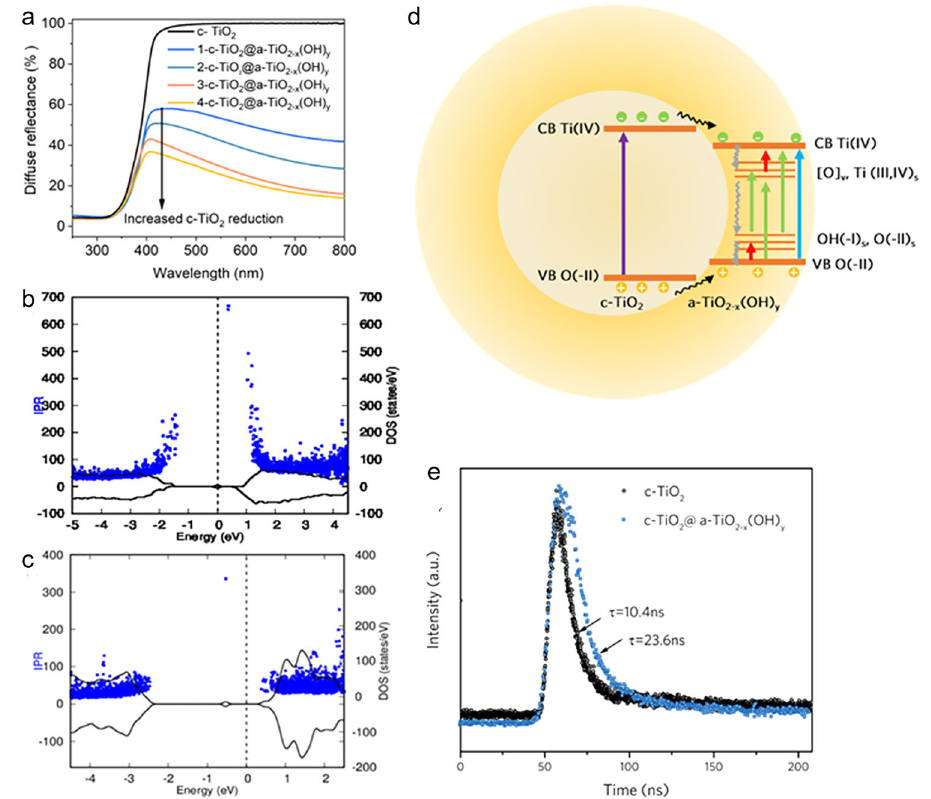
d Schematic of charge carrier separation and transfer pathways in c-TiO 2 @a- TiO 2-x (OH) y .The colorsof arrowsindicatethewavelengthofincidentlight. e Time- resolved photoluminescence spectroscopy decay curves of c-TiO 2 and c-TiO 2 @a- TiO 2-x (OH) y